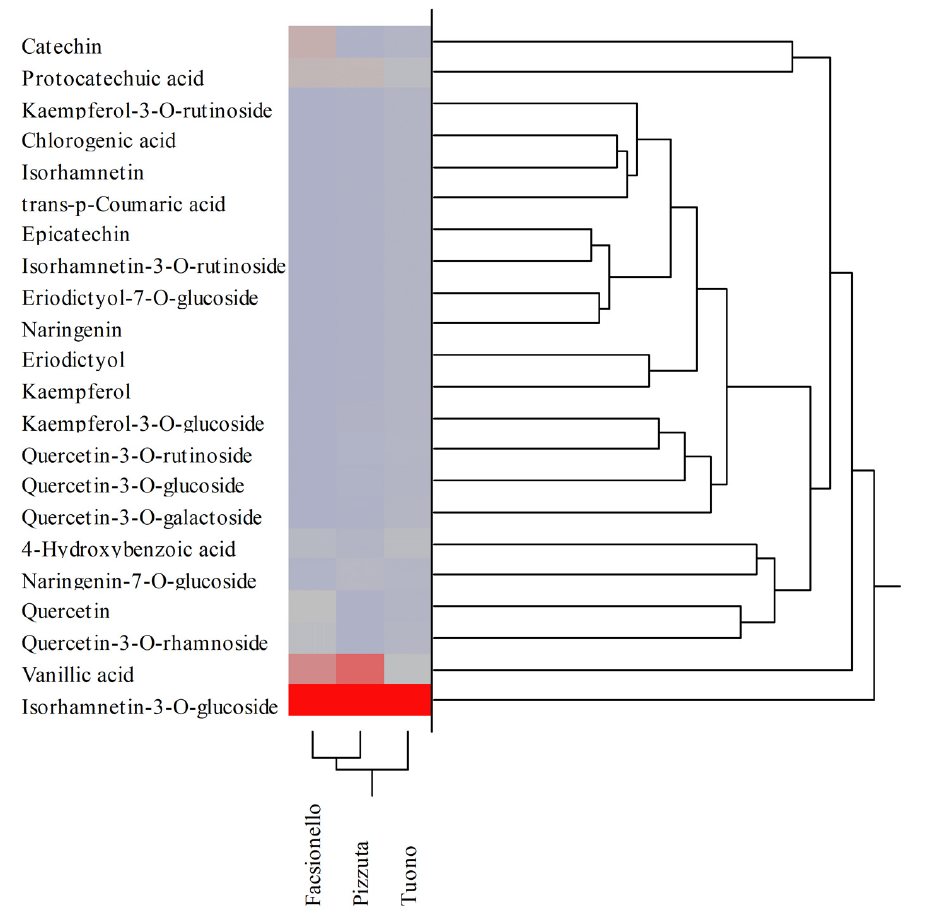
Figure 4. Agglomerative two-way hierarchical clustering analyses of the polyphenolic profiles of blanch water extracts (BWE) belonging to Fascionello, Pizzuta, and Tuono cultivars.